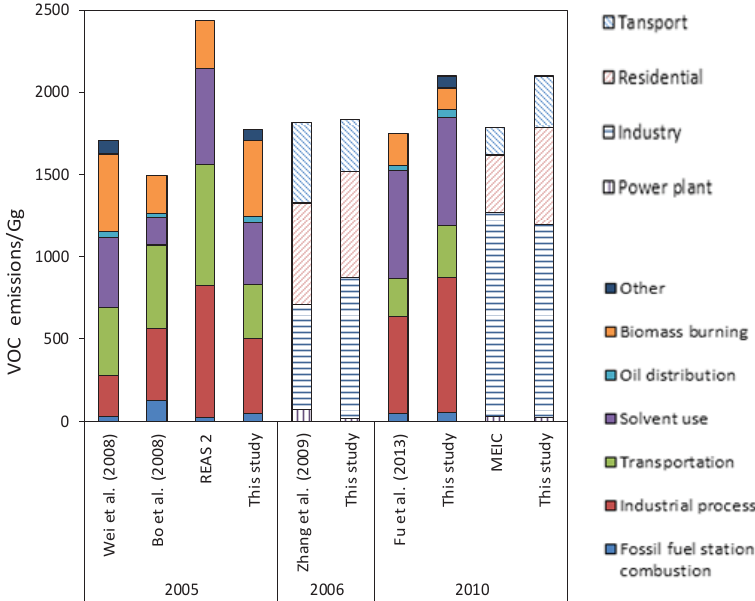
Figure 8. Jiangsu’s anthropogenic NMVOC emissions by sector for selected years estimated from this work and other inventories. Note that emissions in this work are regrouped to be consistent in source categories with Zhang et al. (2009) and MEIC for direct comparison.